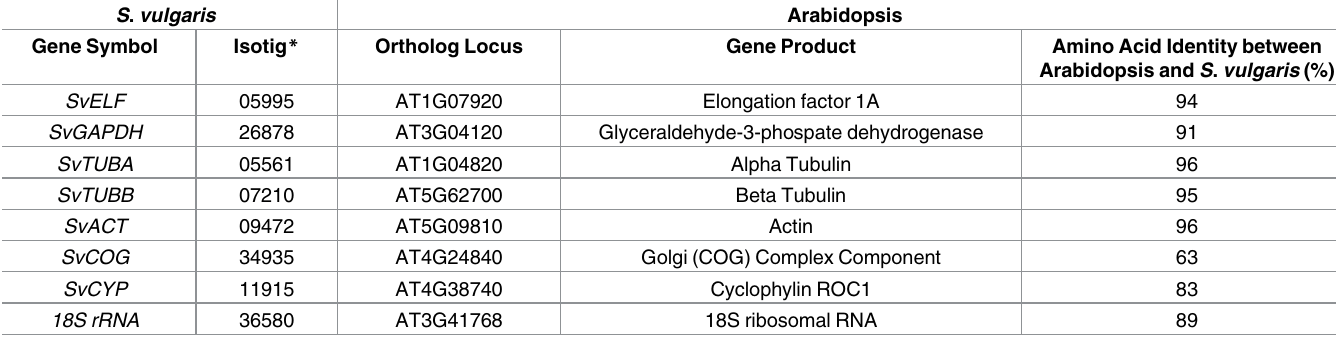
Table 1. Description of Silene vulgaris candidate referencegenes.